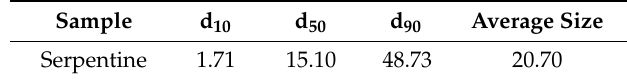
Table 2. The particle size analysis of serpentine ( µ m).